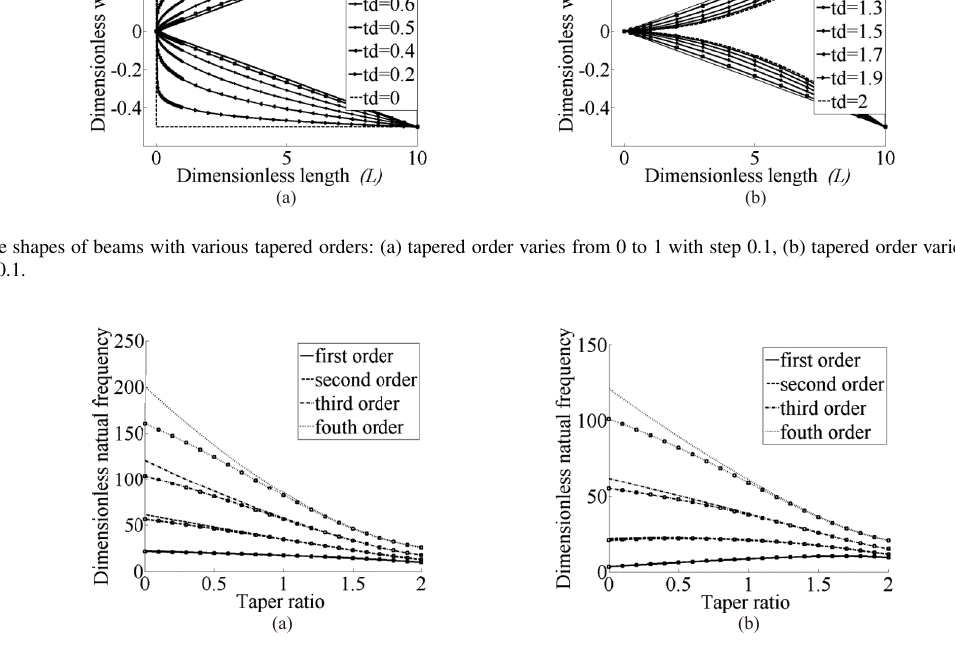
Fig. 8. The variation of first four natural frequencies with tapered orders of a wedge beam: (a) free-free boundary condition, (b) free-clamped boundary condition. The line with “ (cid:2) ” are the results of Timoshenko beam, without “ (cid:2) ” are the results of Euler-Bernoulli